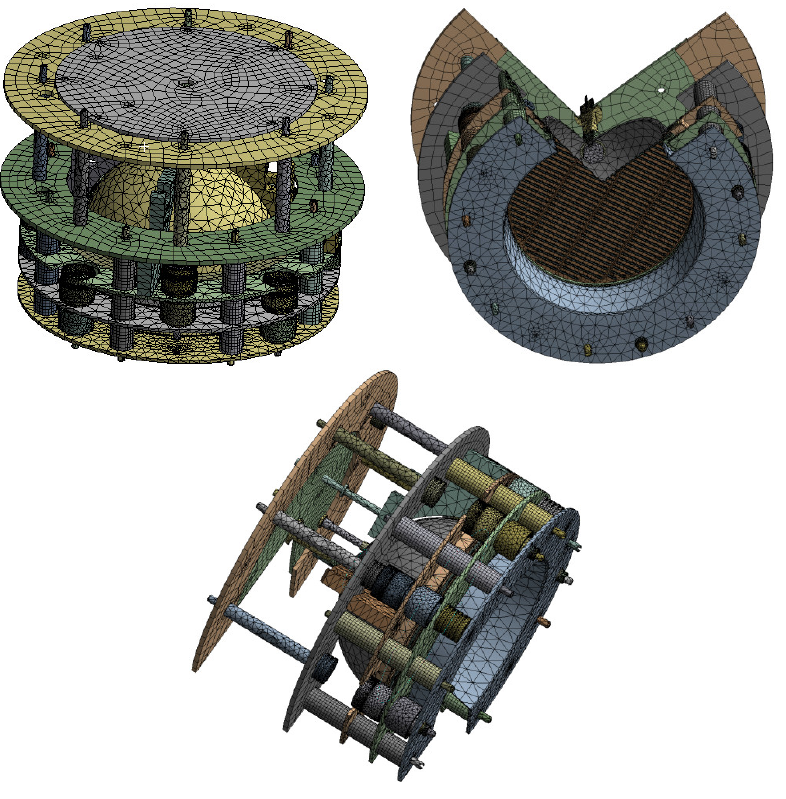
Figure 2. IS discrete elements.